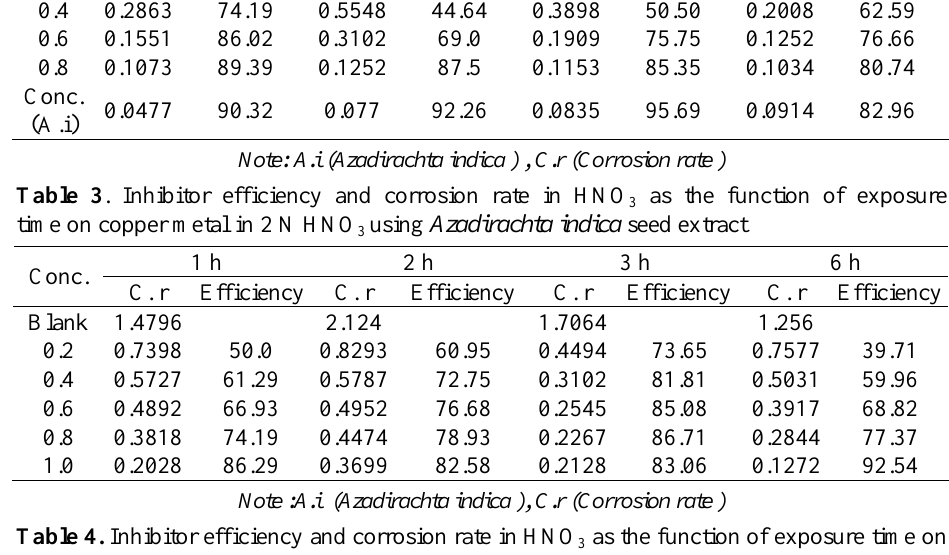
as the function of exposure time on 3